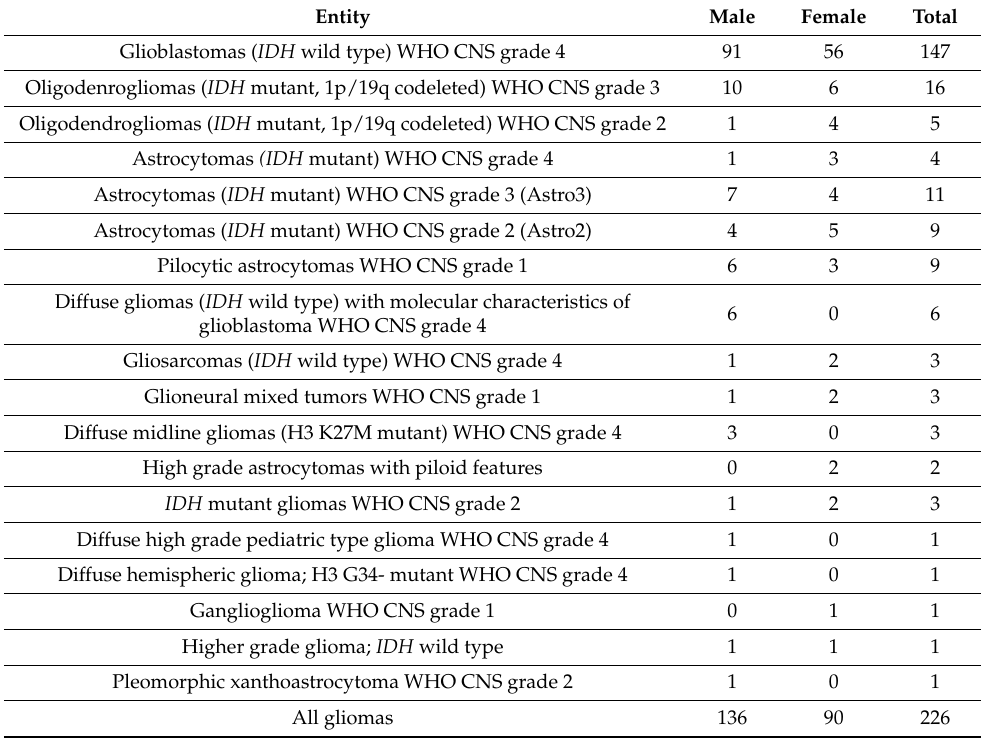
Table 1. Summary of all 18 included WHO CNS 2021 tumor entities by gender.